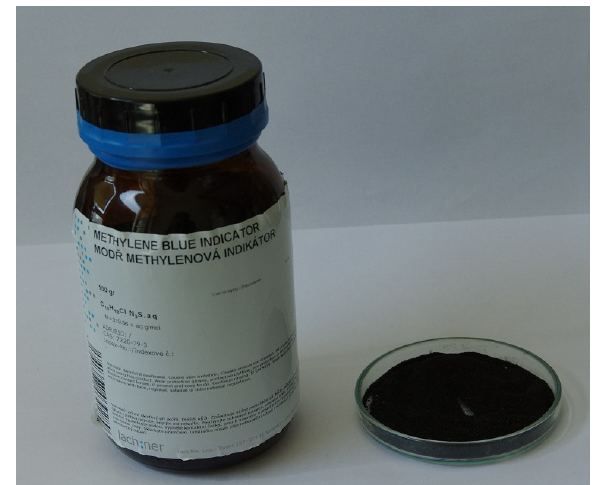
Figure 1. Methylene blue dye.